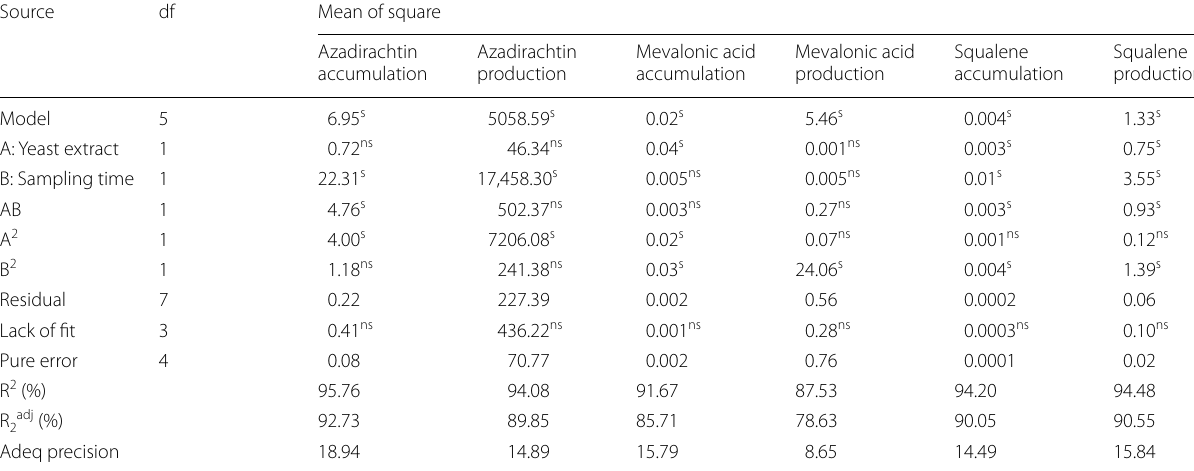
s and ns significant and non-significant,